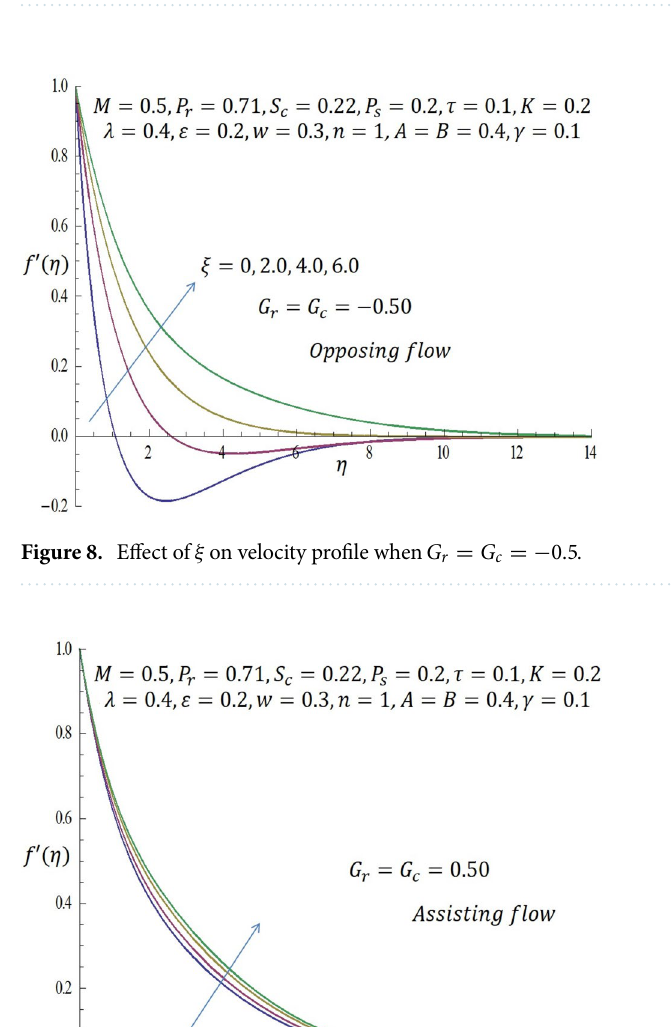
Figure 7. Effect of ξ on shear stress profile when G r = G c = 0.5.